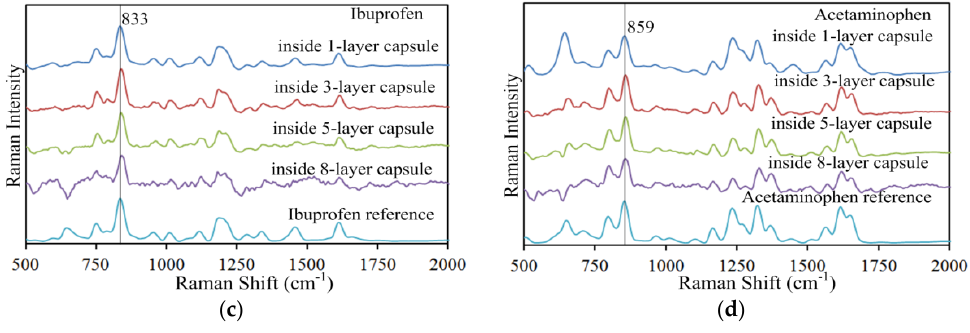
Figure 9. Pure component spectra of ( a ) urea; ( b ) capsule; ( c ) ibuprofen; and ( d ) acetaminophen resolved from mixed-contribution SORS spectra and identified by SID values.